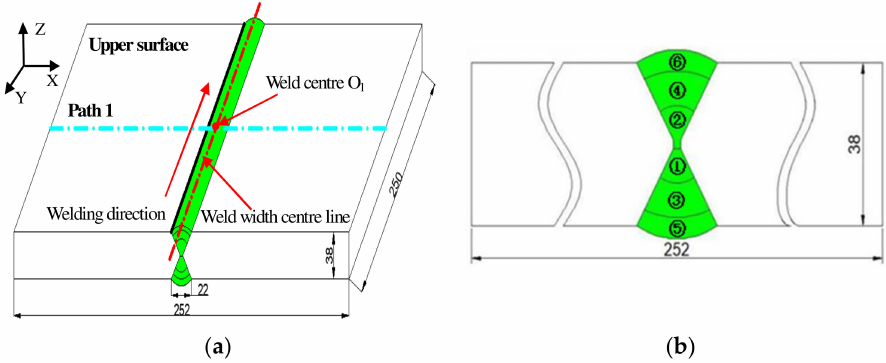
Figure 2. Model I (in mm): ( a ) geometric dimensions and weld path; ( b ) welding sequence ( 1 (cid:13) – 6 (cid:13) ).